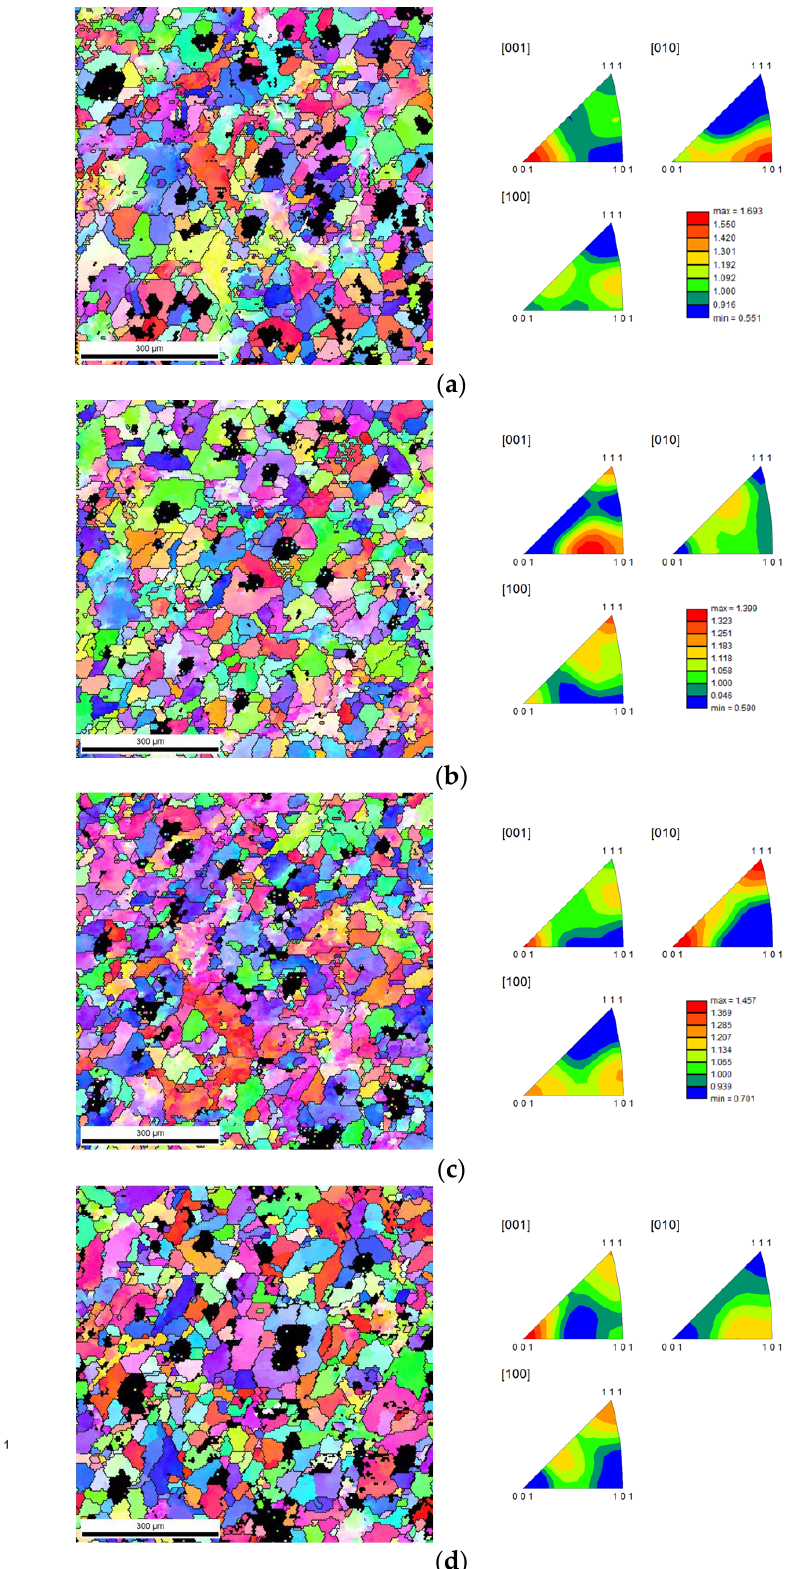
Figure 11. Inverse pole figure (IFP) maps in [001] direction superimposed with image quality images and inverse pole figures for each sample: ( a ) noP Un , ( b ) CP Un , ( c ) LCP Un , and ( d ) TP Un .